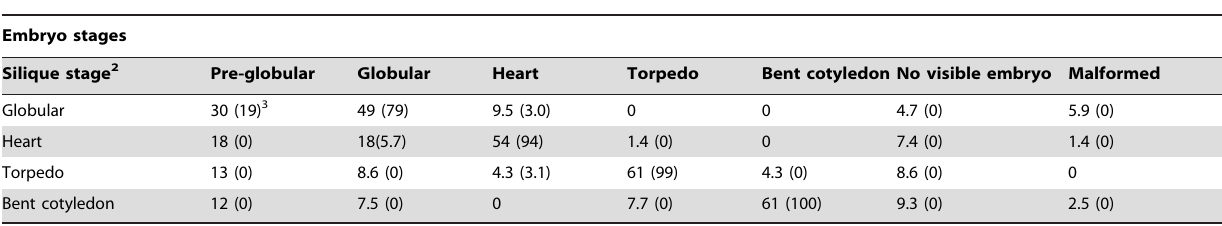
Table 3. Development of ape1L-1 , ape2-1 embryos in siliques at different stages of development 1 .